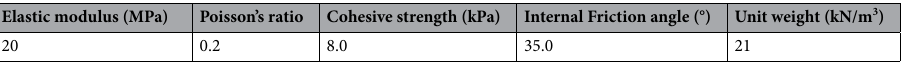
Elastic modulus